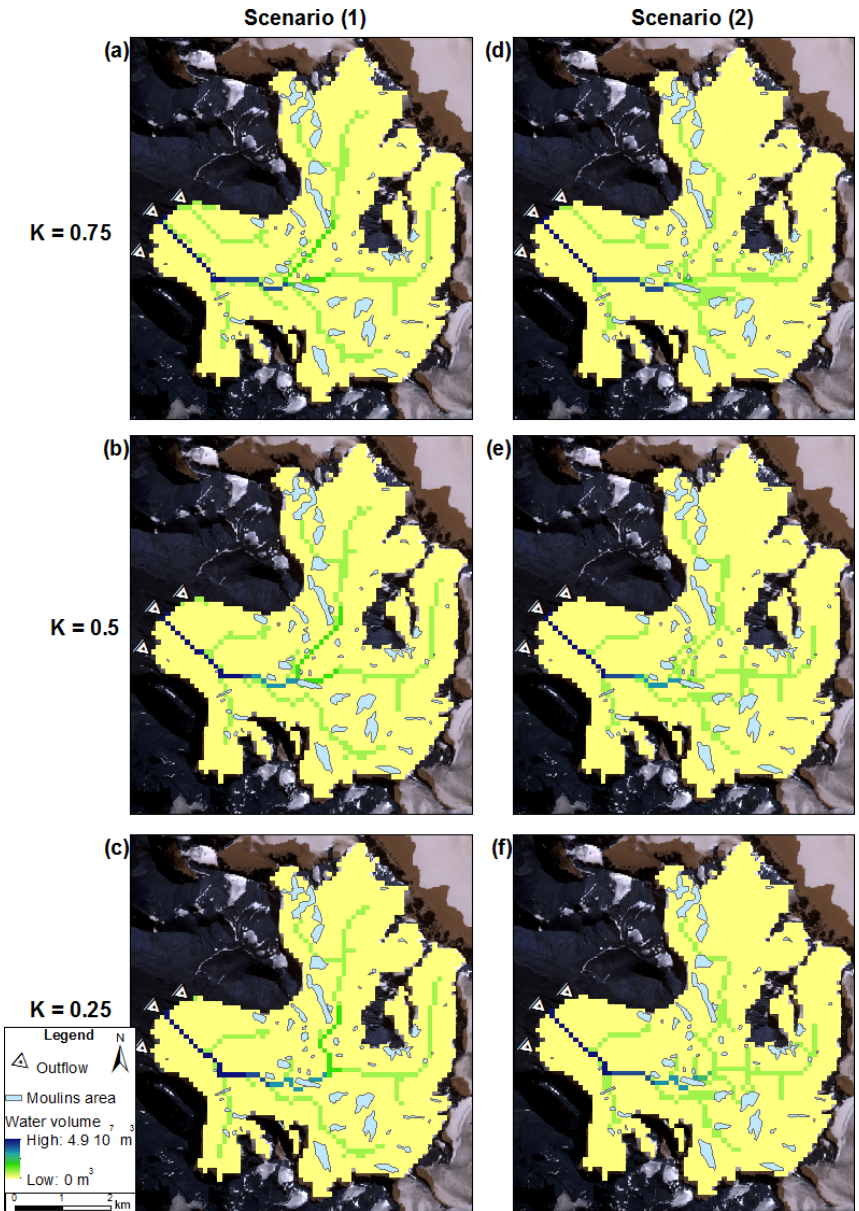
Figure A2. Map of the theoretical pattern of subglacial channels in Werenskioldbreen modeled with scenarios (1) – K = 0 . 75 (a) , K = 0 . 5 (b) , K = 0 . 25 (c) – and (2) – K = 0 . 75 (d) , K = 0 . 5 (e) , K = 0 . 25 (f) . The map background is a WorldView-2 VHRS image acquired on 21 August